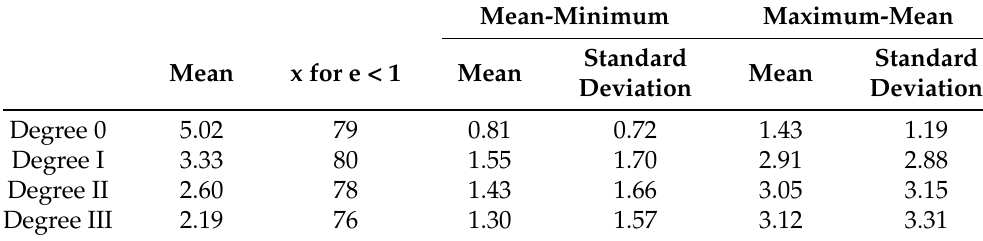
Table 2. Summary of results (women).